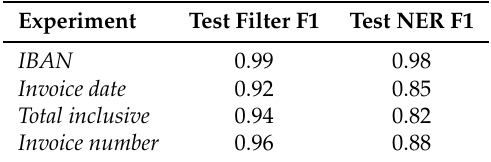
Table 4. Results of NER in the financial use case in terms of F1.